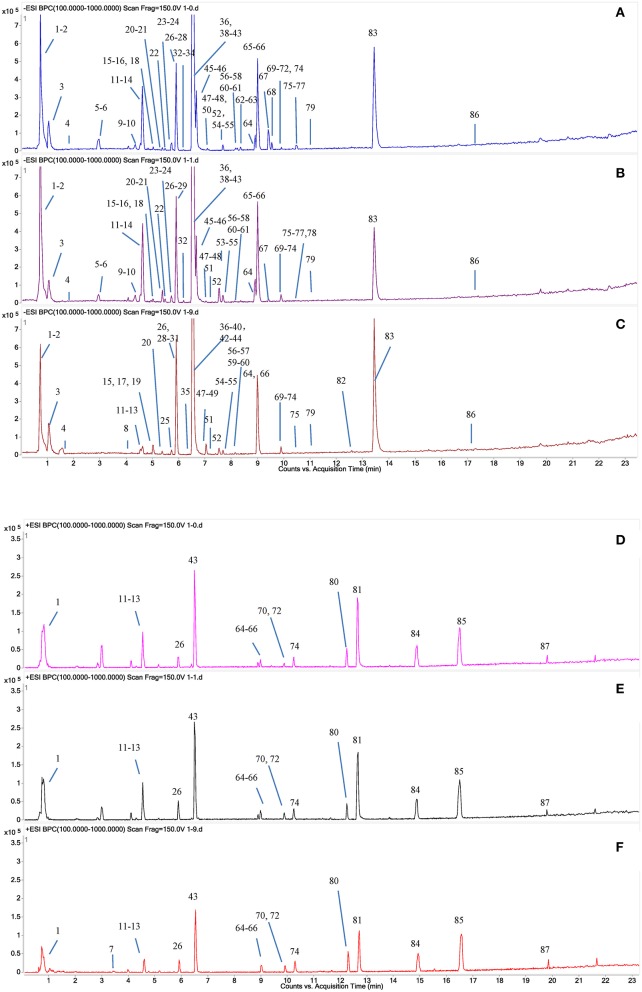
Typical UPLC-QTOF-MS/MS chromatograms of secondary metabolites in PMR. (A,D) RPMR; (B,E) PPMR1; (C,F) PPMR9; (A–C) negative mode; (D–F) positive mode. The peak numbers represent the same meanings as in Table 1.